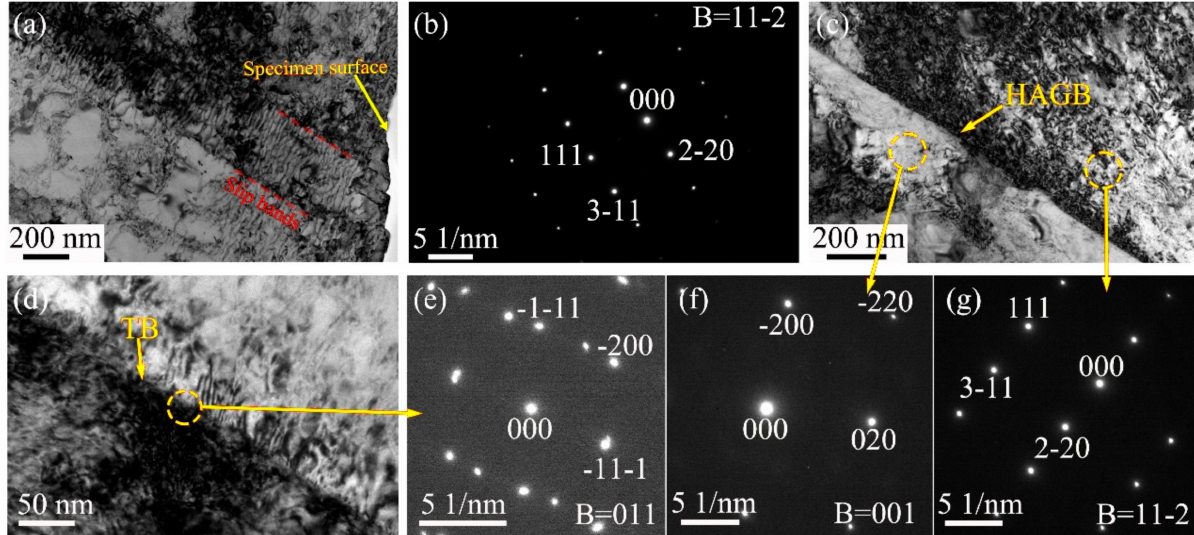
Figure 7. The bright-field images of the dislocation in the abnormal grain interior of the original joint at 20% global strain ( a ) and the corresponding selected area electron diffraction (SAED) of the matrix via B = 11-2 ( b ). The dislocation morphology at the HAGB ( c ), the twin boundary ( d ), and corresponding SAED patterns ( e – g ).